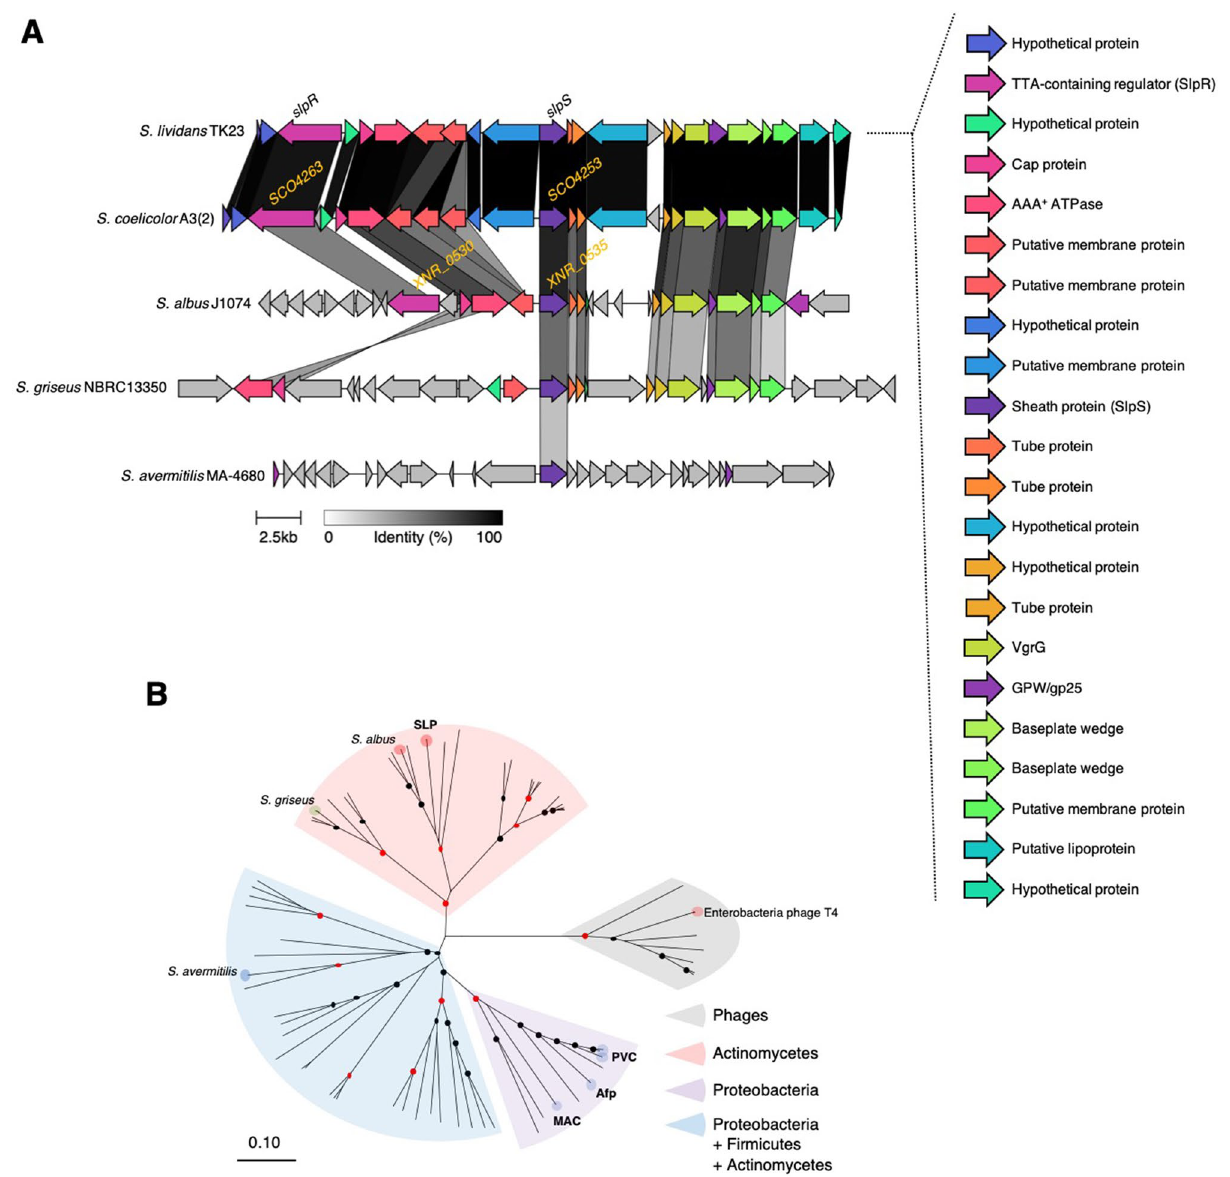
Figure 1. Phylogenetic analysis of eCIS-related genes in Streptomyces species. eCIS-related genes are conserved among Streptomyces . ( A ) Organizations of eCIS-related genes that are conserved in the model Streptomyces species. ( B ) A phylogenetic tree of eCIS and SLP proteins. The tree was constructed based on 72 amino acid sequences of tube proteins using the neighbor-joining method. Red and black circles indicate the clades with the bootstrap values of 100 and 85–99, respectively. The evolutionary distances were computed using the p-distance method and are in the units of the number of amino acid differences per site. Afp, anti-feeding prophage; PVC, Photorhabdus virulence cassettes; MAC, metamorphosis-associated contractile